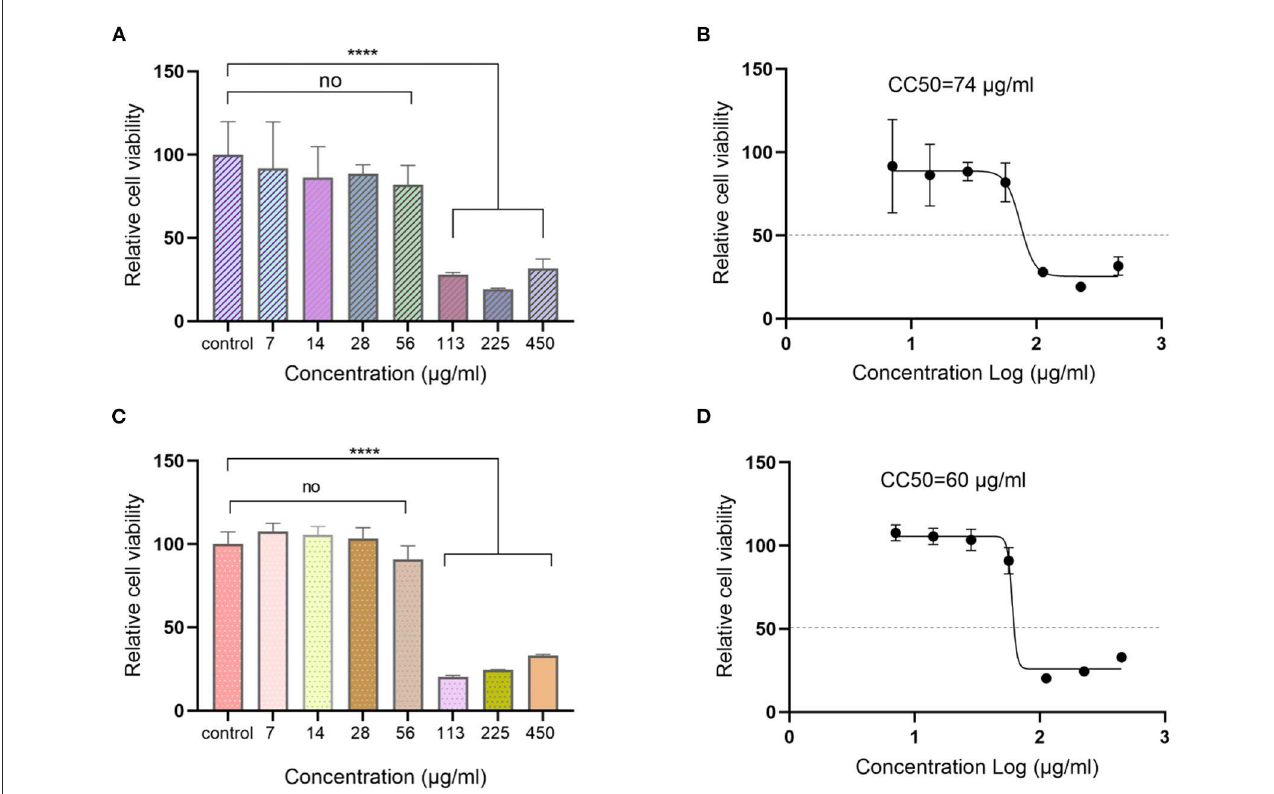
FIGURE1 Cytotoxicity assay of Ren’s oligopeptide. (A) Viability of MDCK cells at different concentrations of Ren’s oligopeptide. (B) 50% cytotoxicity concentration (CC50) of Ren’s oligopeptide on MDCK cells. (C) Viability of Vero-E6 cells at different concentrations of Ren’s oligopeptide. (D) 50% cytotoxicity concentration (CC50) of Ren’s oligopeptide on Vero-E6 cells. ns, not significant ( p > 0.05); **** p < 0.0001 from the Student’s t -test. Error bars represent SD from three independent